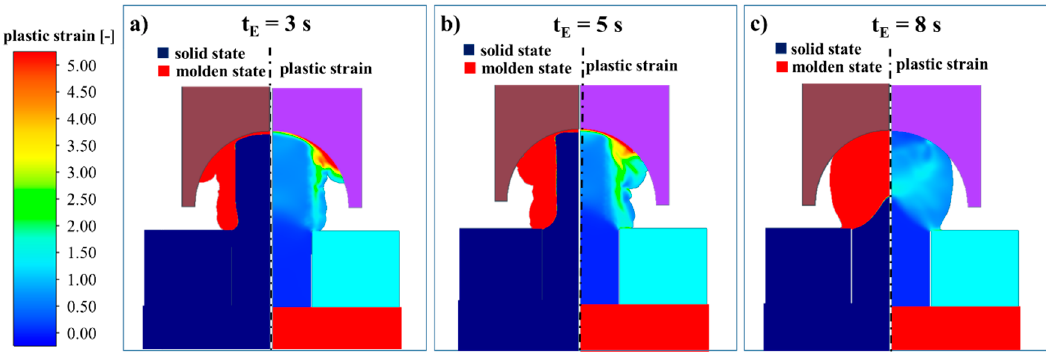
Figure 12. Numerical analysis of the mold filling behavior characterized by the plastic strain as well as the molten and solid material areas for a joining path of 80% and different heating times t E of ( a ) 3 s, ( b ) 5 s and ( c ) 8 s.